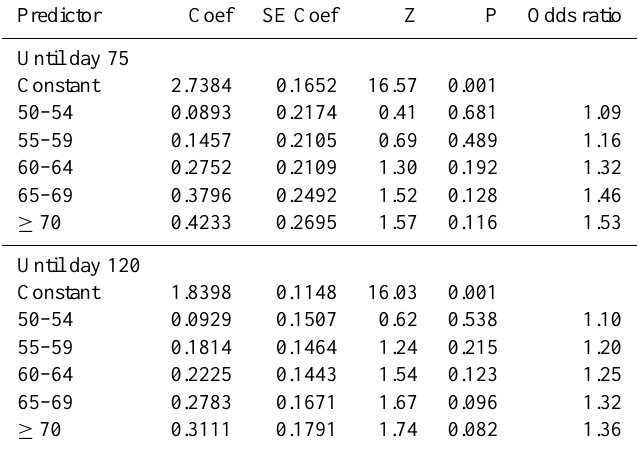
Predictor Coef SE Coef Z P Odds